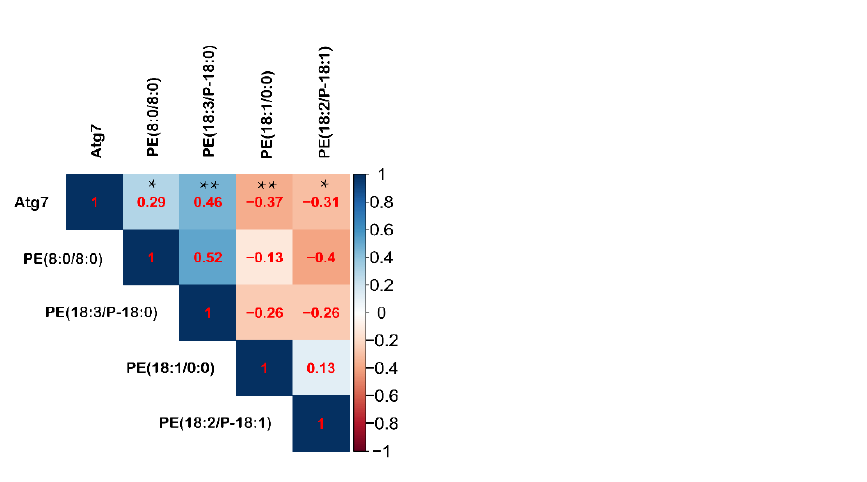
Figure 10. Correlation analysis between intestinal Atg7 and serum PE. Correlation analysis is conducted by the Pearson’s correlation. * means p ≤ 0.05, ** means p ≤ 0.01.